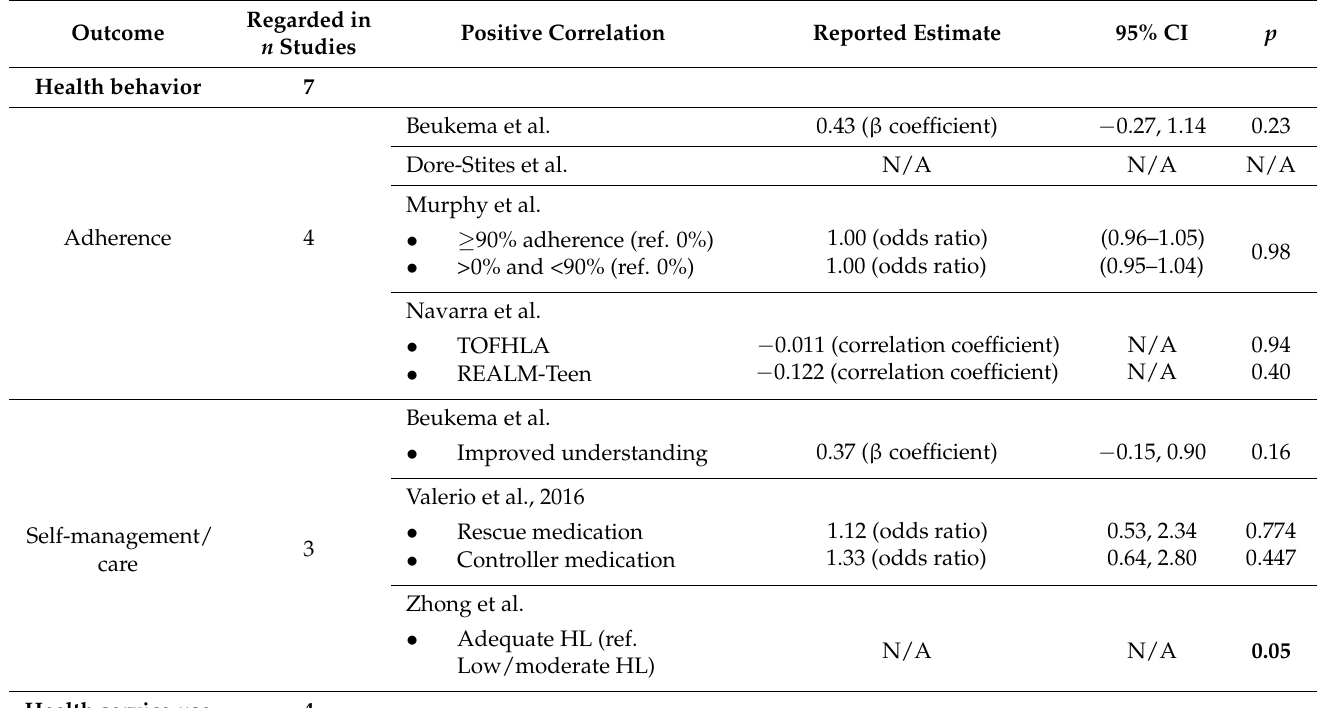
Table A3. Influence of health literacy on